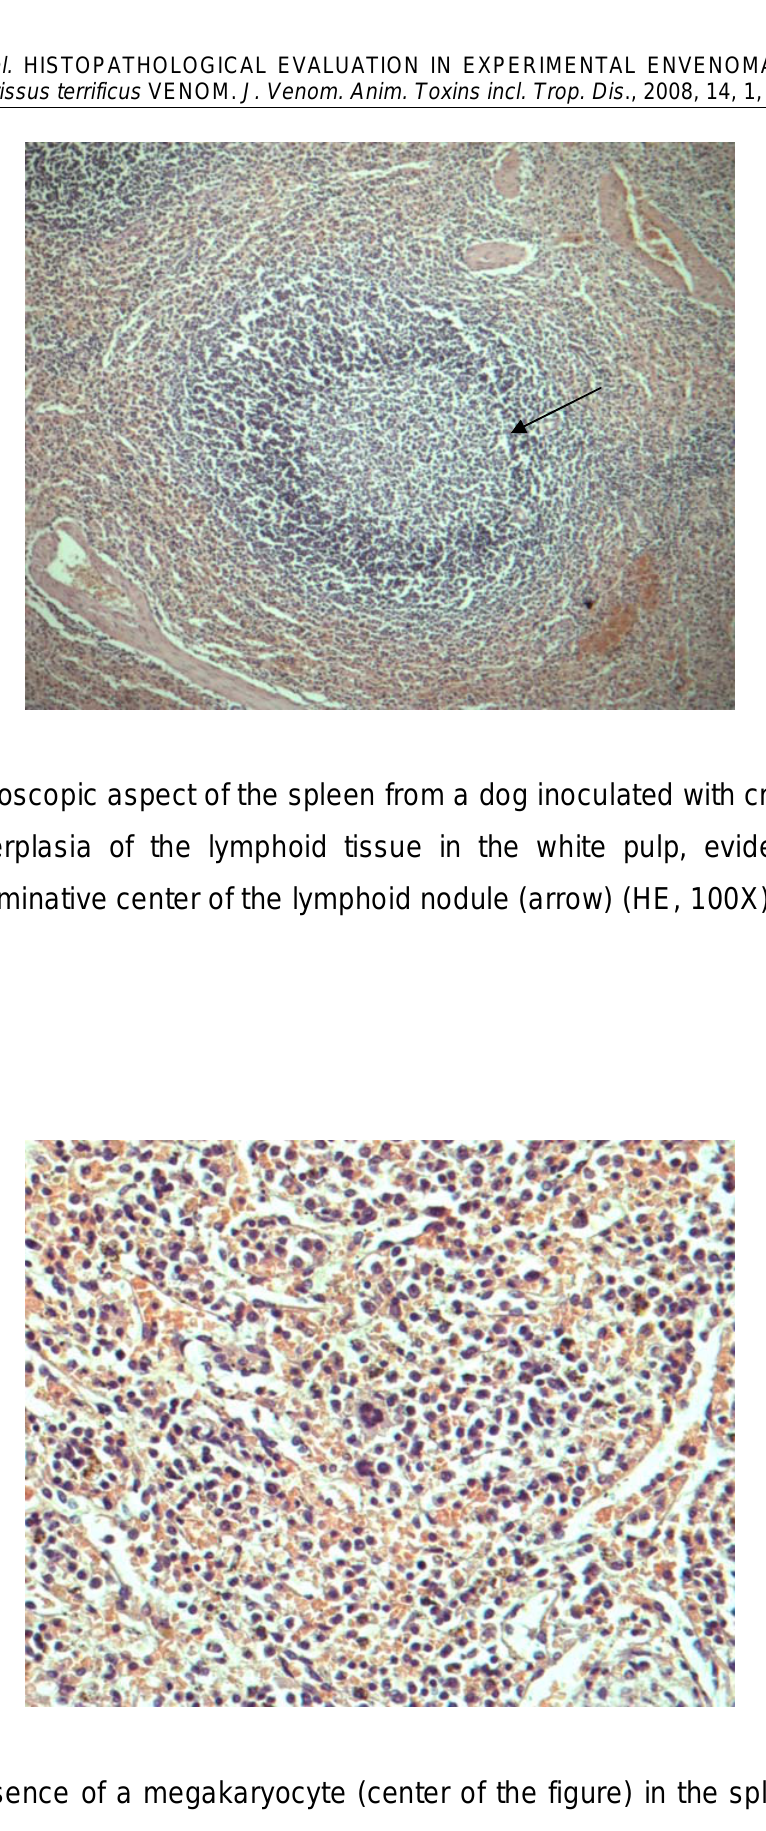
Figure 9. Presence of a megakaryocyte (center of the figure) in the spleen, showing extramedular hematopoiesis (HE,